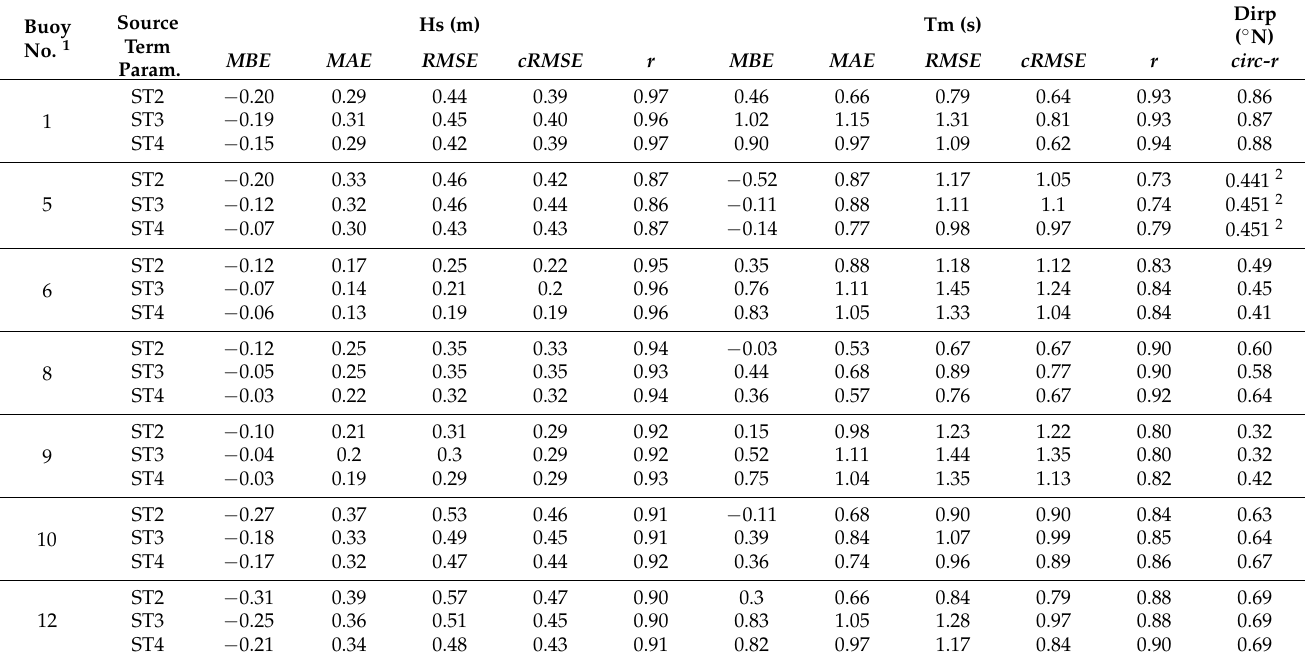
Table 7. Statistical indicators for Hs, Tm and Dirp (or Dirm) evaluated for the ST2, ST3 and ST4 source term parameteriza- tions with 60 s time step and N scheme. Source Buoy Term No. 1